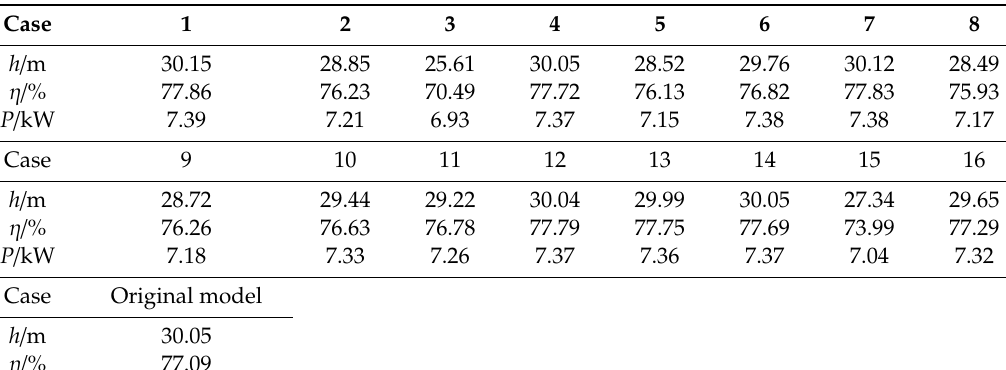
Table 7. 1.4 Q numerical simulation